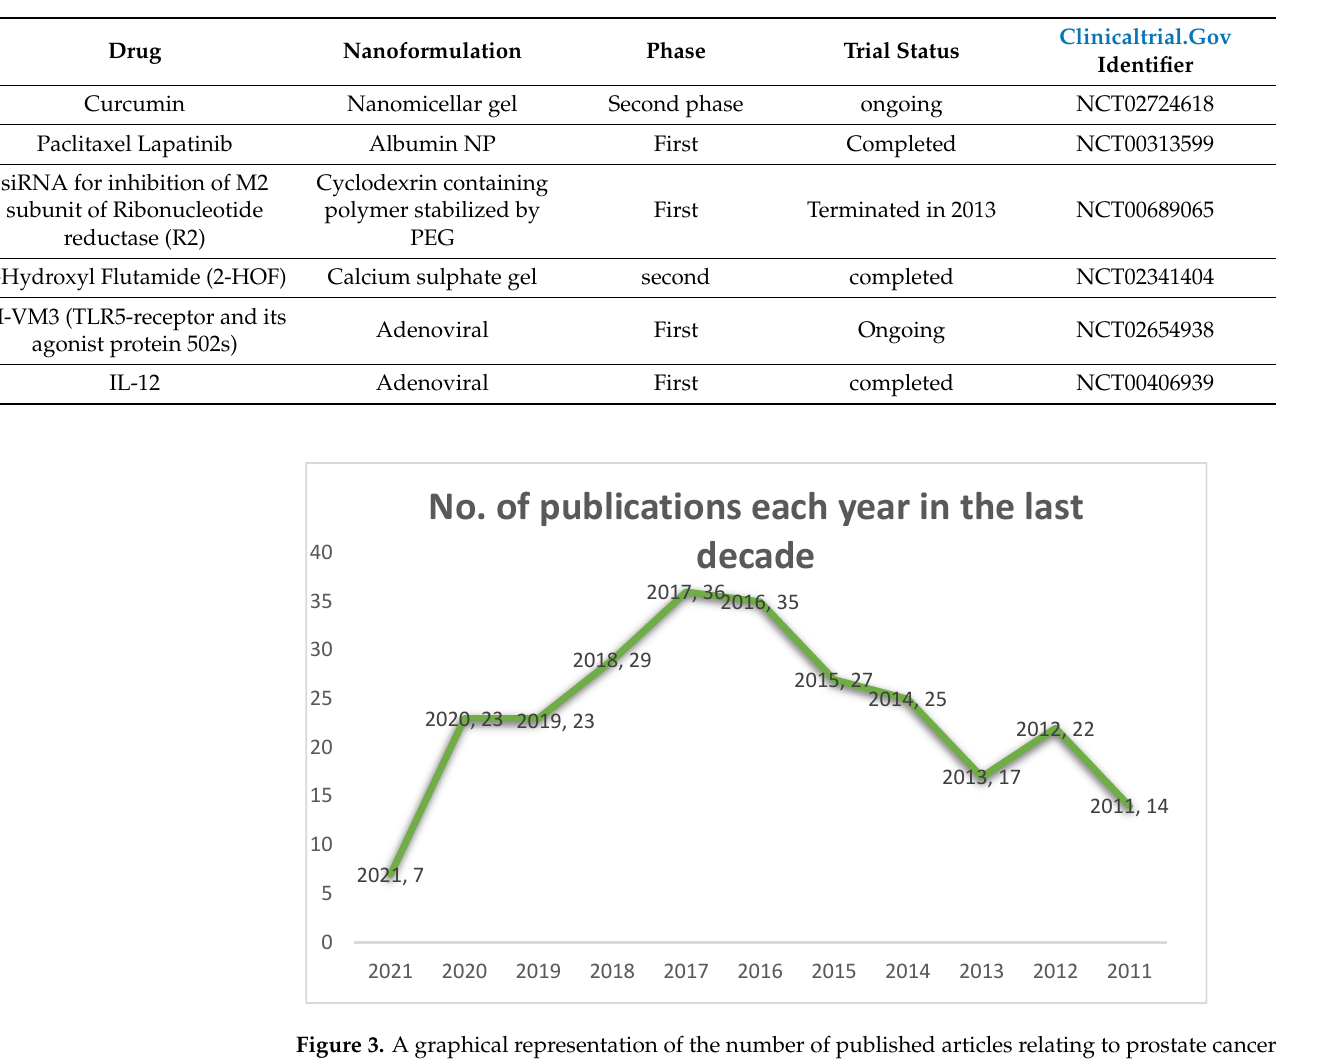
Table 4. Tabulation of the nanovectorization-based drugs in clinical trials for prostate cancer treatment (adapted from Reference [92]. Drug